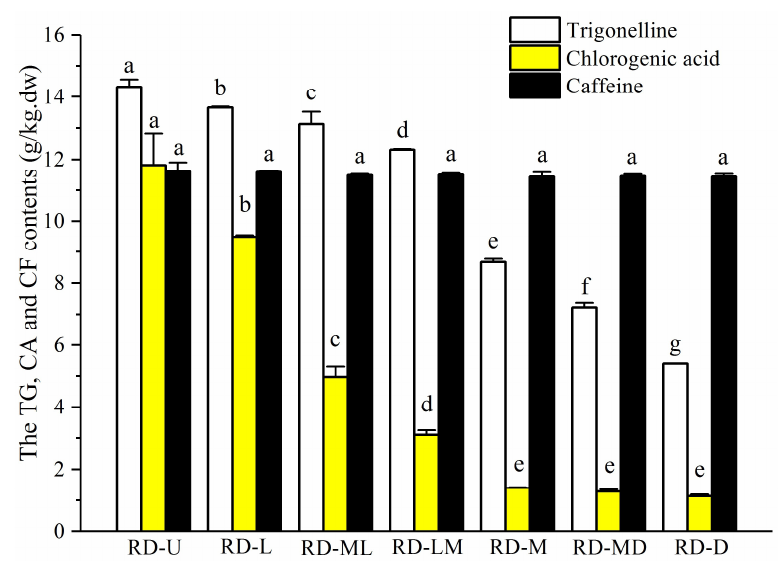
Figure 3. The trigonelline (TG), chlorogenic acid (CA), and caffeine (CF) contents of the seven roasting degrees of the coffee beans. Different lowercase letters show significant differences among the groups at P < 0.05. The vertical bars represent means ± SD, n = 3. RD-U: unroasted; RD-L: light; RD-ML: moderately light; RD-LM: light medium; RD-M: medium; RD-MD: moderately dark; and RD-D: dark.